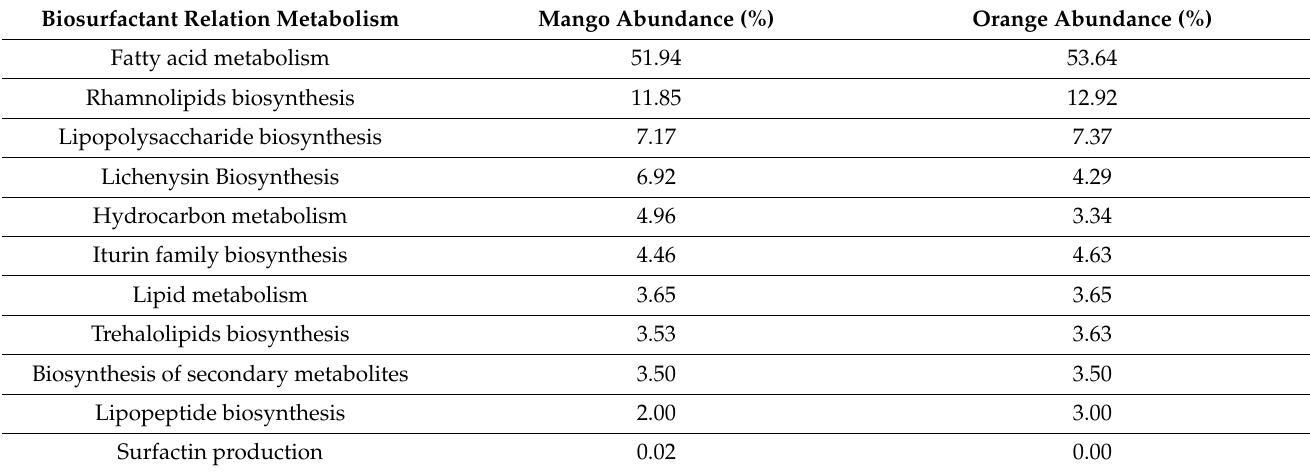
Table 1. Abundance (%) of predicted gene clusters in enriched fruit samples related to the production of